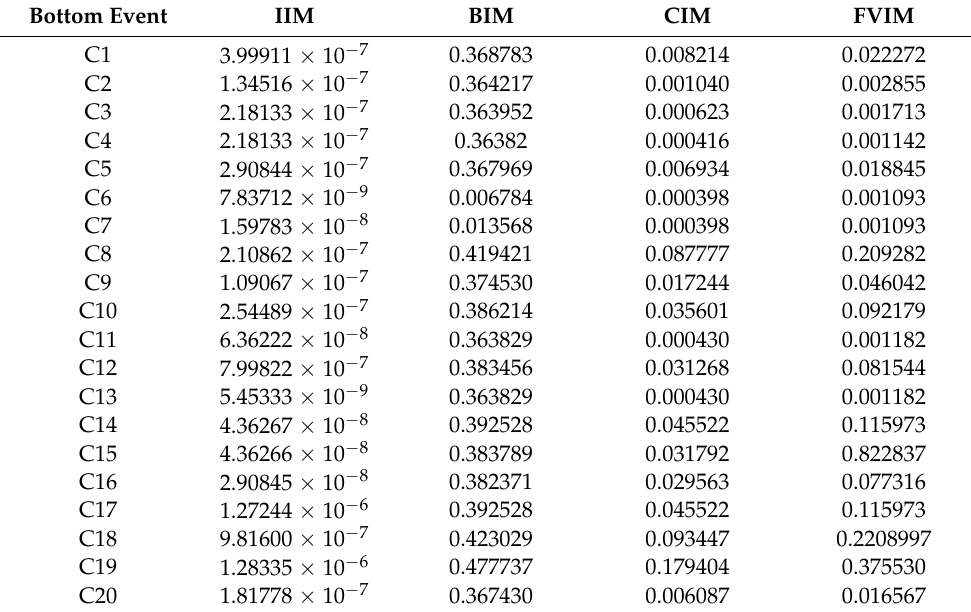
Table 6. The results of four IMs for 20 bottom